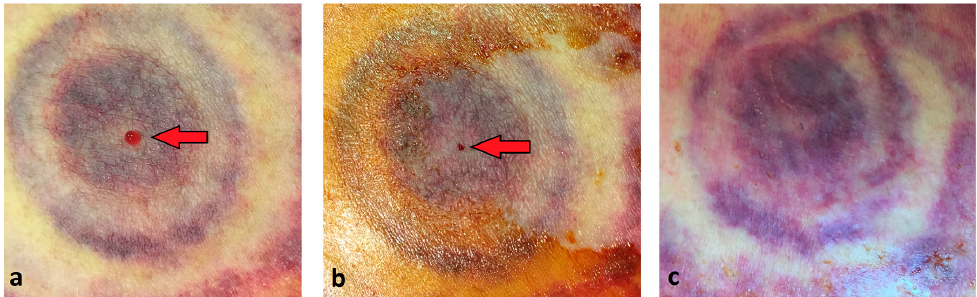
Figure 2. Ascites leak after autologous blood injection. ( a ) Leakage of ascitic fluid as indicated by the arrow. ( b ) Autologous blood has been injected and ascites leak has stopped immediately following procedure. ( c ) No recurrence of leak noted at 24 h.